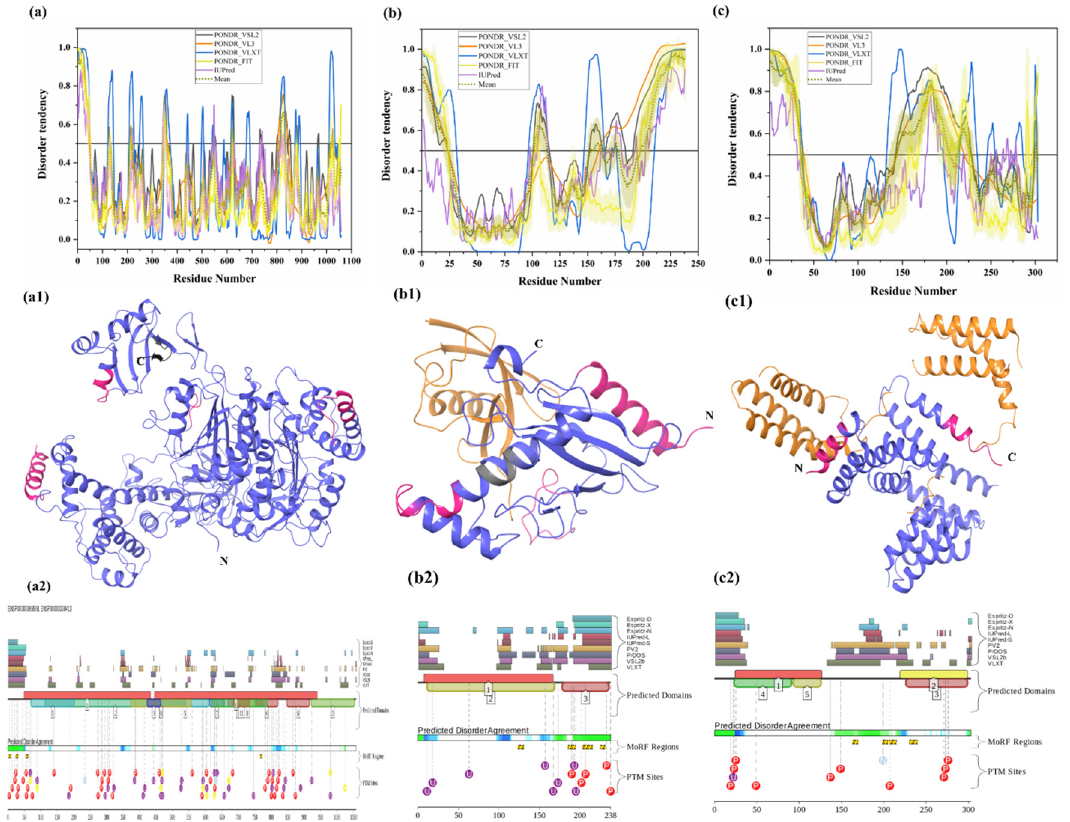
Figure 4. Intrinsic disorder in ubiquitinating enzymes E1 (UBA1), E2 (UBE2R2) and E3 (STUB1). ( a ) ubiquitin-activating enzyme E1 (UniProt ID: P22314), ( a1 ) crystal structure of the E1 enzyme (PDB ID: 6DC6). ( b ) ubiquitin-conjugating enzyme E2 (UniProt ID: Q712K3), ( b1 ) crystal structure of E2 enzyme having residues 1–202 (PDB ID: 6NYO). ( c ) E3 ubiquitin ligase (UniProt ID: Q9UNE7), ( c1 ) crystal structure of E3 ubiquitin ligase (PDB ID: 4KBQ). In Plots ( a – c ), the outputs of PONDR ® VSL2, PONDR ® VL3, PONDR ® VLXT, PONDR ® FIT, and IUPred are represented by black, orange, blue, yellow, and purple lines, respectively. Mean disorder profile, calculated by averaging the outputs of five predictor-specific per-residue disorder profiles, is depicted by olive color. Light-olive shadow around the mean curve represents the error distribution for the mean. The light-yellow shadow around the PONDR ® FIT curve shows error distribution for PONDR ® FIT. In ( a1 ), crystal structure of the E1 enzyme (PDB ID: 6DC6) is represented in faded blue color, disordered residues are shown in salmon pink color, and MoRF residues identified by MoRFCHiBi_Web server (1048–1057) are shown in grey color. In ( b1 ), E2 enzyme (1–202 length with missing residues 1–5 and 193–202 at N- and C-terminal, respectively) is shown with Ubiquitin-60S ribosomal protein L40 (RPL40A; orange color). In ( c1 ), Hsc70 Lid-Tail domains (orange color) in complex with E3 ubiquitin ligase (which is represented in faded blue color); disordered residues in E3 are shown in salmon pink color. In ( a2 , b2 , c2 ), functional disorder profiles, MoRFs, and PTMs in E1, E2, and E3 enzymes using D2P2 server have been shown.